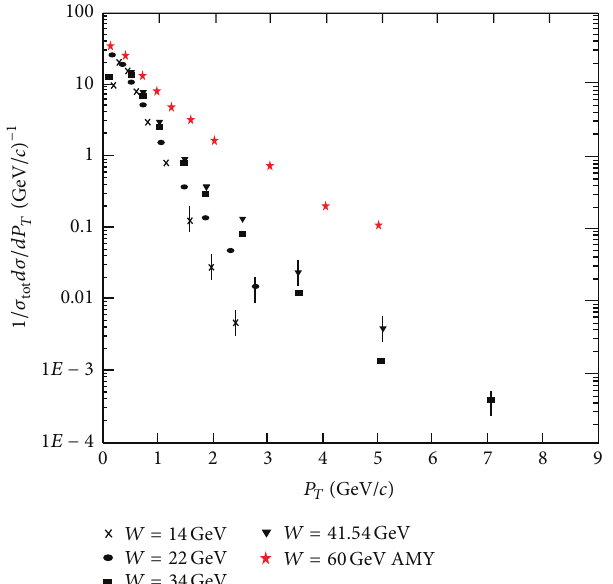
Figure 7: Normalized differential cross section as a function of the transverse momentum of the charged particles, ((1/𝜎 tot )(𝑑𝜎/𝑑𝑃 𝑇 )) , for different center of mass energies [11].